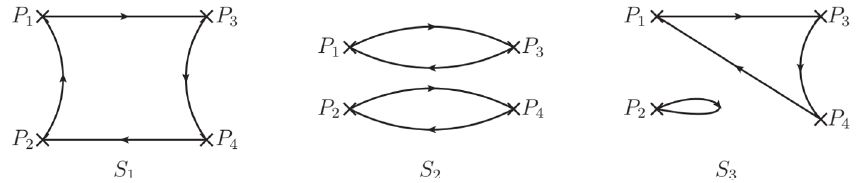
Figure 12 . Sketches of meson-meson scattering in the rescattering contributions of C , E , P diagrams (left), T diagram (middle) and A diagram